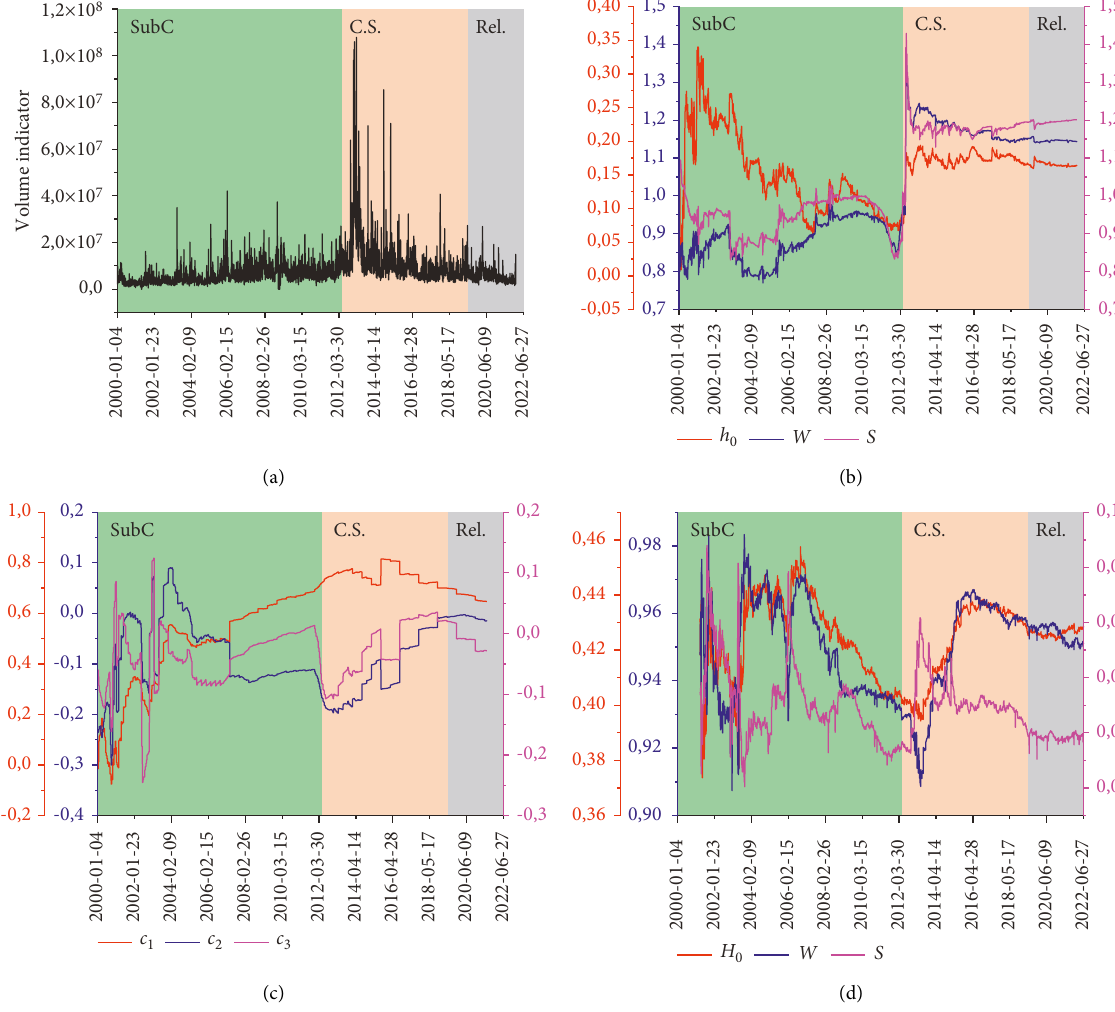
Figure 4: Financial time series and time series of multifractal spectrum shape parameters for Sony Group Corporation. The symbol “C.S.” denotes the critical state, and the symbol “Rel.” denotes the relaxation. (a) Volume indicator, (b) WTMM method, (c) WL method, and (d) MF-DFA method.